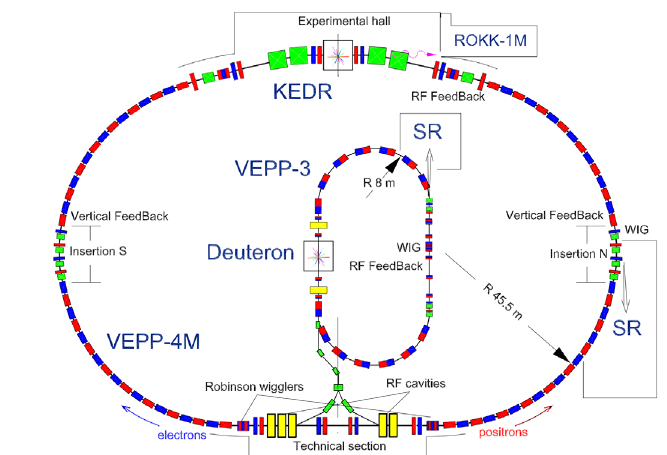
Fig. 2 VEPP-4 layout. Legend: KEDR is the universal superconducting magnet detector for HEP, deuteron is the nuclear physics facility at VEPP-3, SR are the synchrotron radiation halls, ROKK-1M is the external beam test hall.